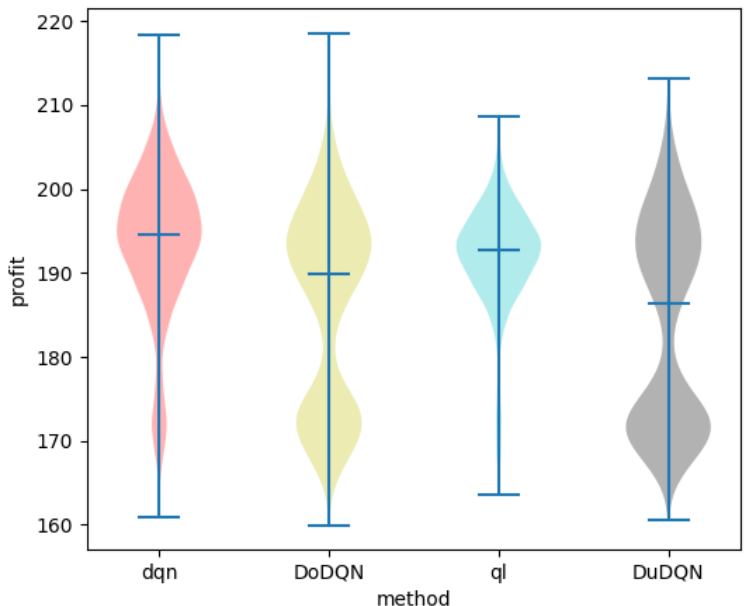
Figure 15. Comparison of utility using different